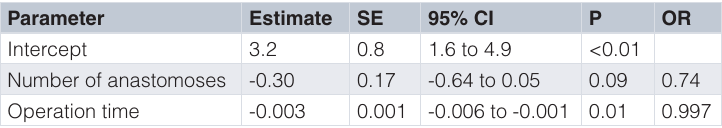
Table 5. Model predicting the odds ratio for no major complications versus major